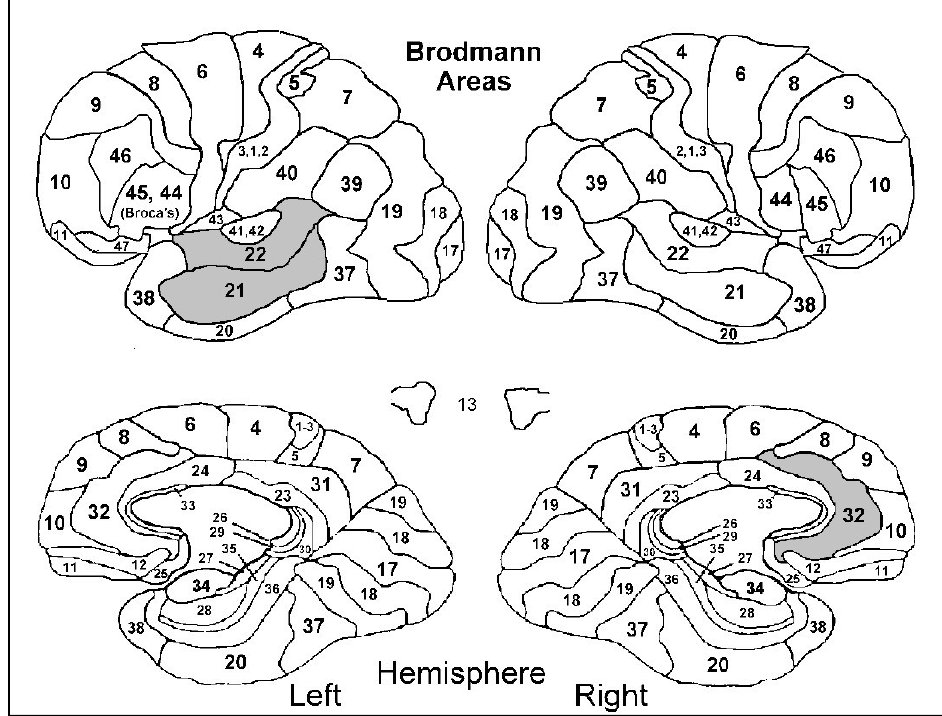
Figure 3. Hypoperfusion in Brodmann areas 21L, 22L, 32R (left middle and anterior temporal cortices and right dorsal anterior cingulate cortex) was significantly associated with a higher anosognosia cognitive